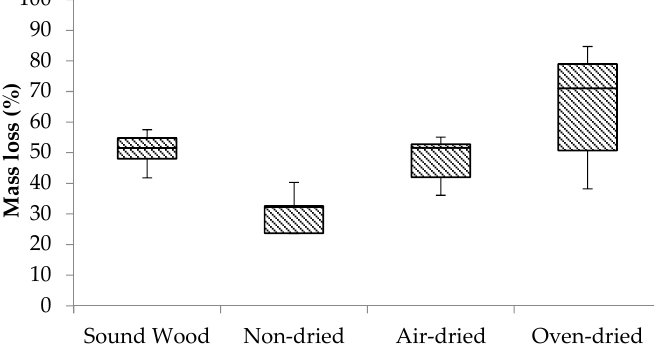
Figure 6. Box plot of mass loss (%) of wood specimens prepared from wood blocks decayed under laboratory condition in the no-choice feeding test.